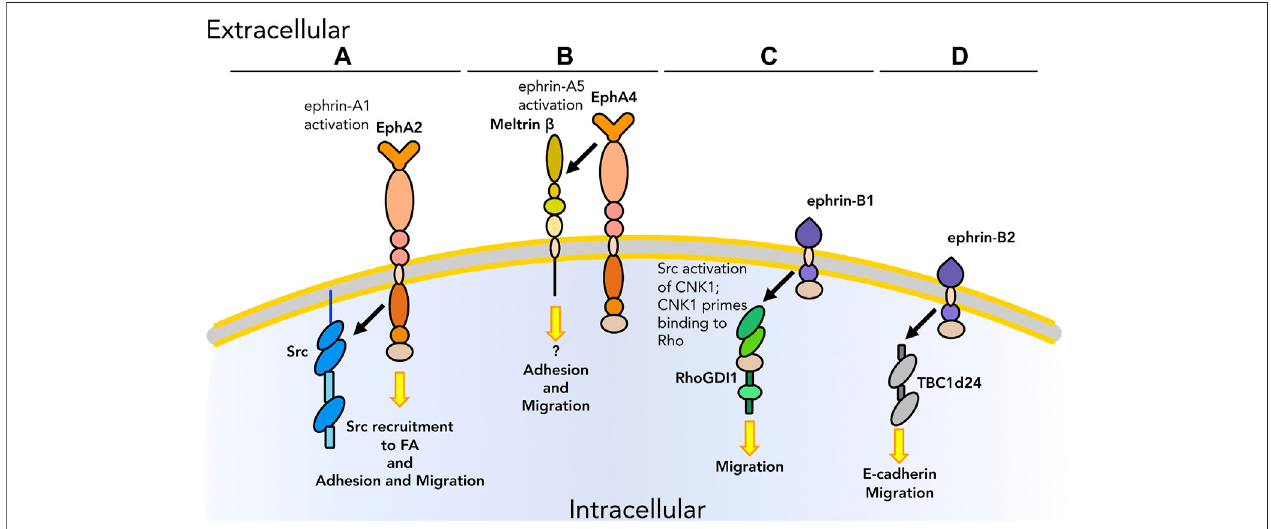
FIGURE 3 | Graphical representation of physical interactions occurring in cis between Ephs/ephrins and other molecules to promote or inhibit cell adhesion and migration. (A) After activation by ephrin-A1 binding, EphA2 promotes the recruitment of Src at FA for the regulation of adhesion and migration. (B) EphA4 interacts with theectodomainofmeltrin β throughitsextracellulardomaintoregulateadhesionandmigrationattheNMJ. (C) ephrin-B1interactswithRhoGDI1toenhancemigrationin tumors. (D) ephrin-B2 interacts with TBC1d24 to modulate migration via E-cadherin in the nervous system. As we know only some of the downstream pathways, unknown downstream effectors are listed with a question mark. Receptors are depicted as single chains for simplicity. References are listed in Table 1